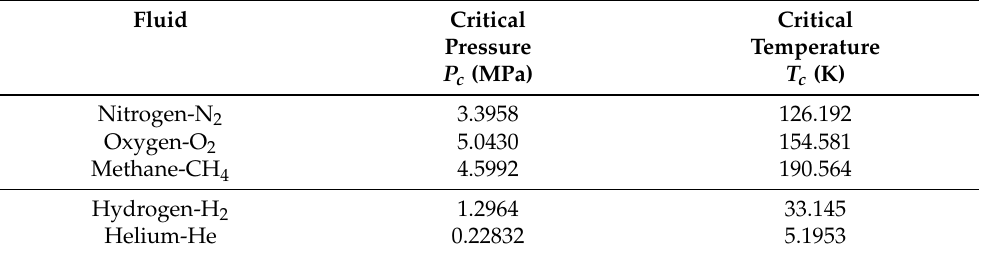
Table 1. Table of respective fluid critical properties of five cryogenic fluids (N 2 , O 2 , H 2 , He and CH 4 ). Data obtained from NIST webbook database